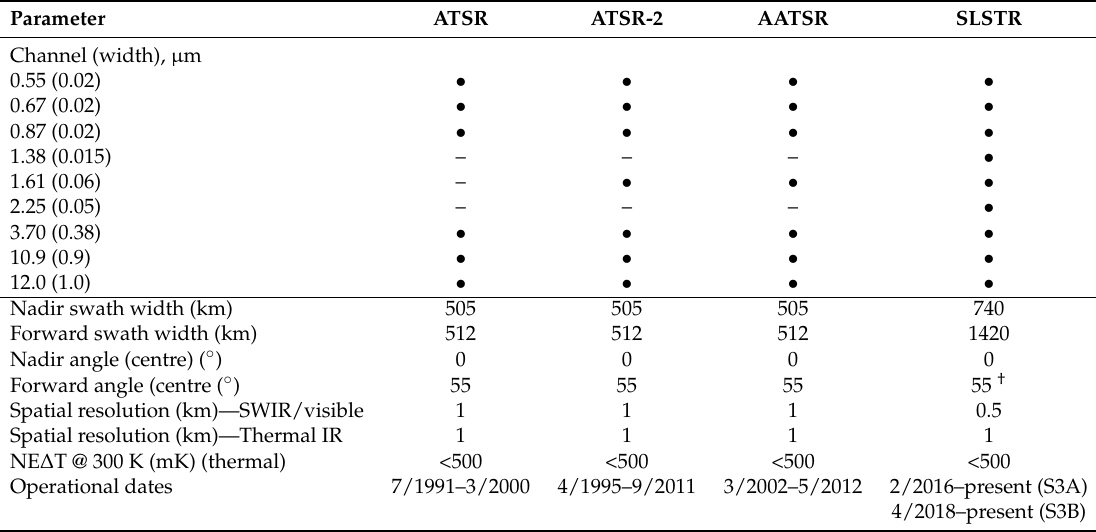
Table 5. Main features of the along-track scanning radiometer (ATSR) family of